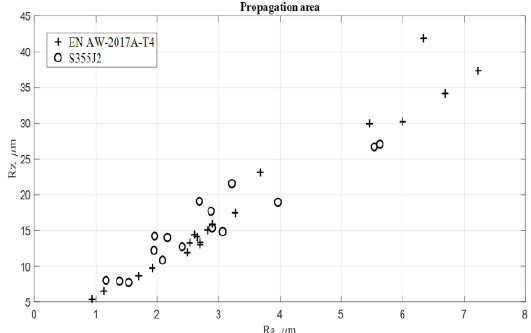
Fig. 8. The relationship between Rz and Ra of propagation